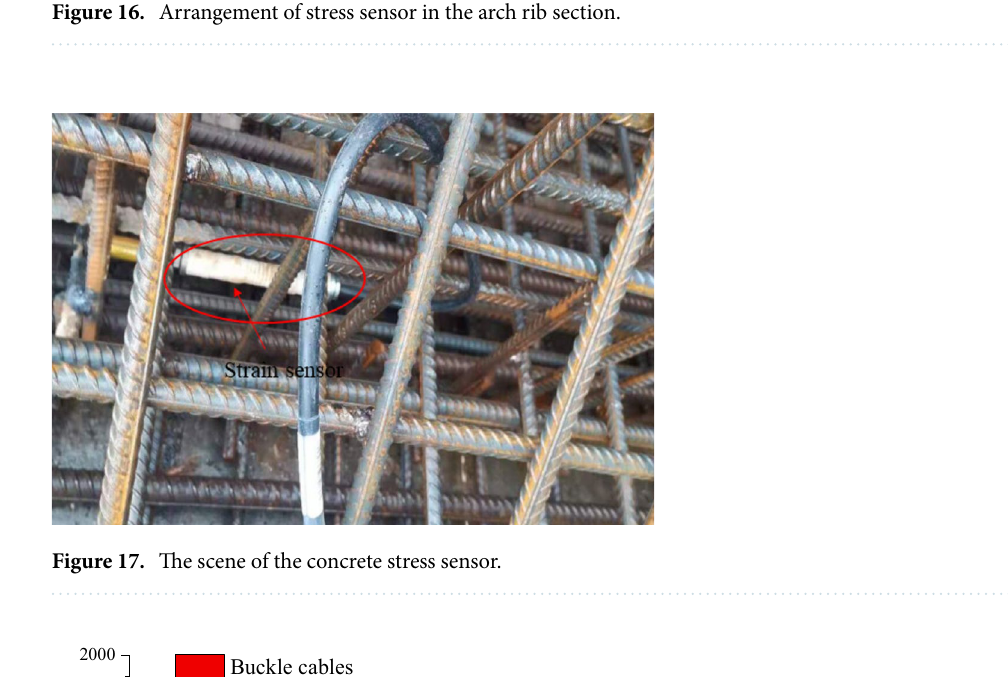
Figure 16. Arrangement of stress sensor in the arch rib section.